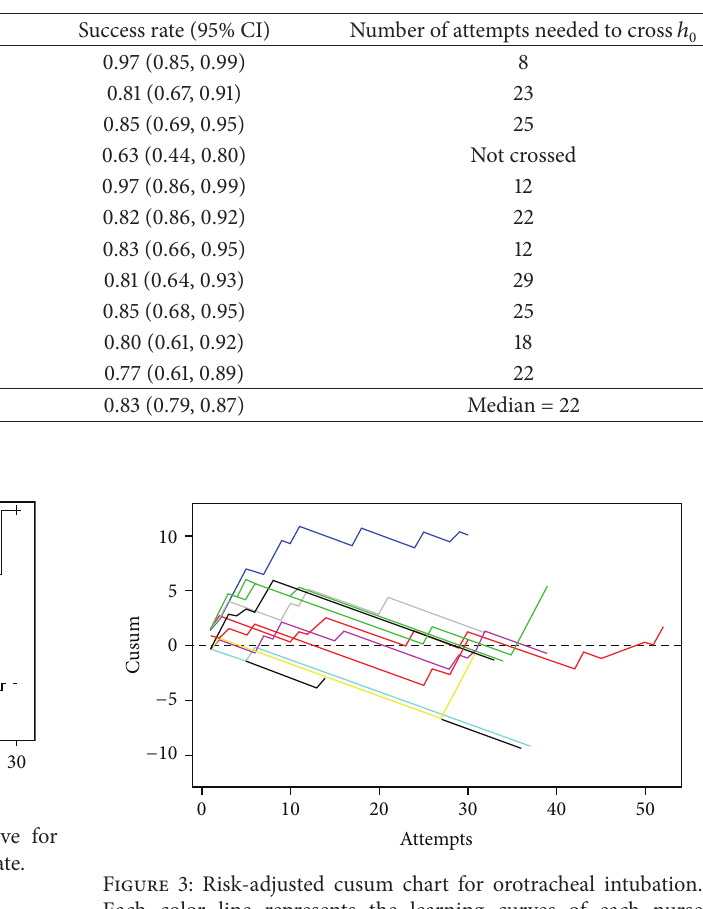
Table 3: Individual results.